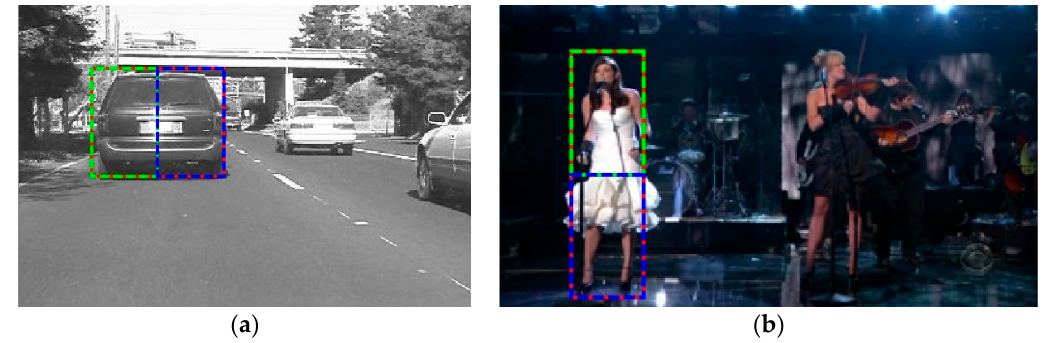
Figure 4. Two spatial distributions based on the ratio of the height and width of the target. The red rectangle represents holistic part, the green and blue rectangles represent two local parts. ( a ) horizontally aligned object from car4; ( b ) vertically aligned object from single1.